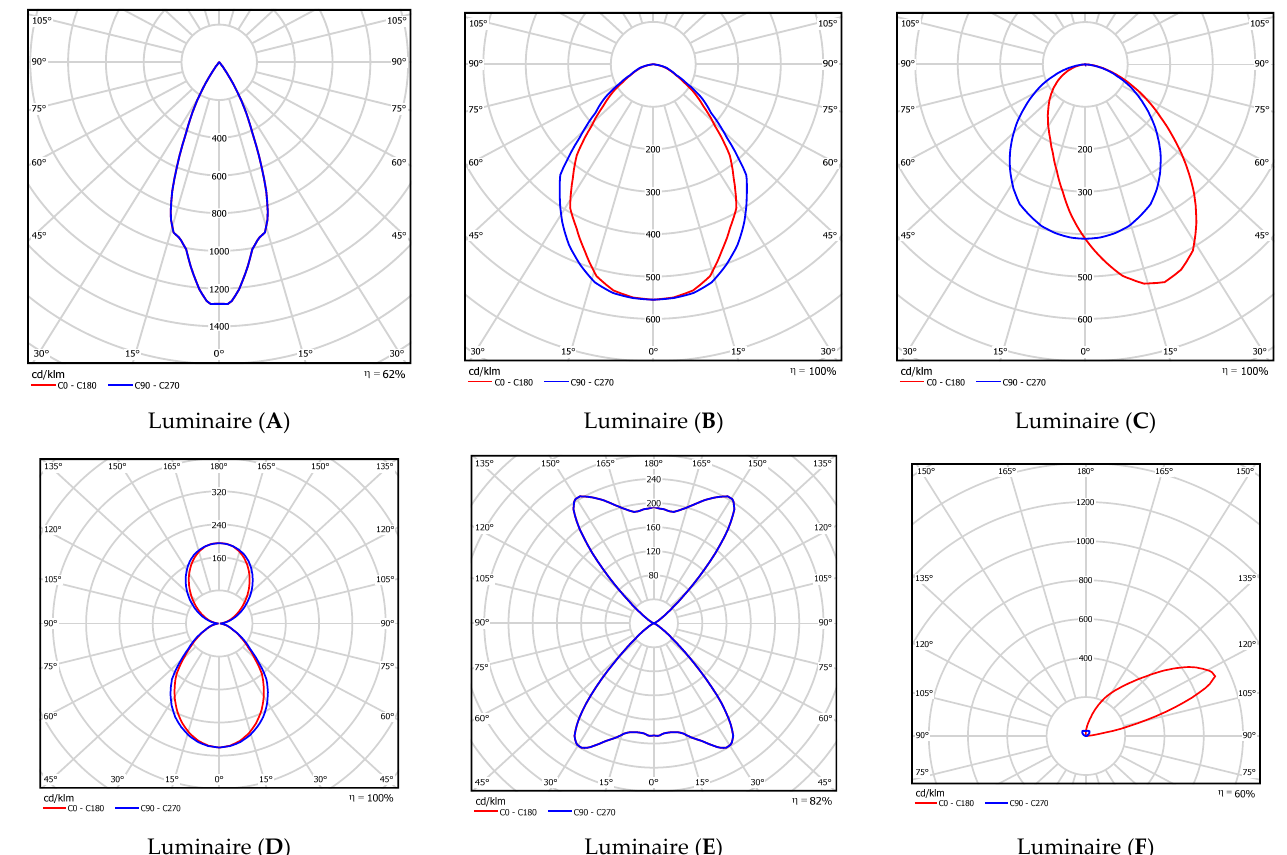
Figure 1. Luminous intensity distribution curves of selected luminaires.